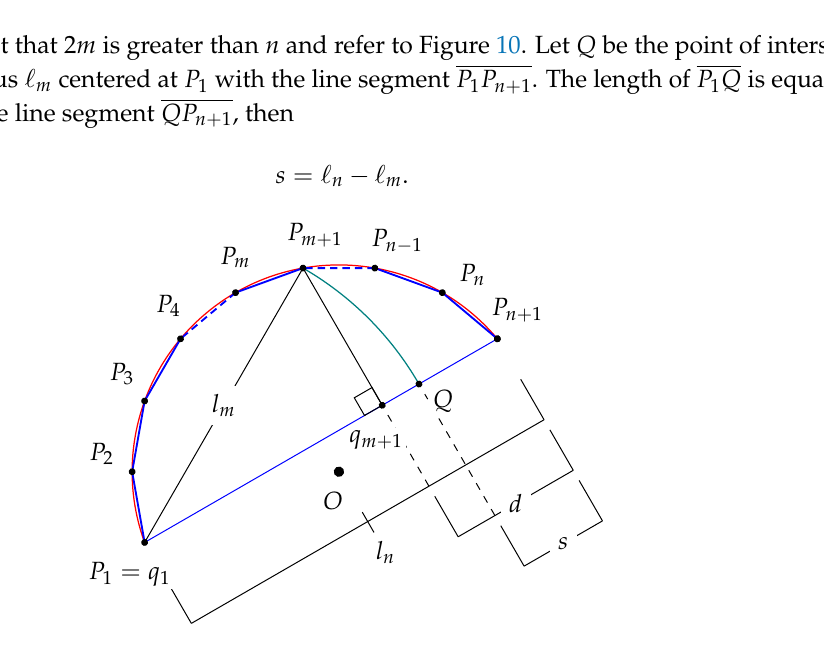
Figure 10. Lengths of chords subtending arcs with different numbers of congruent